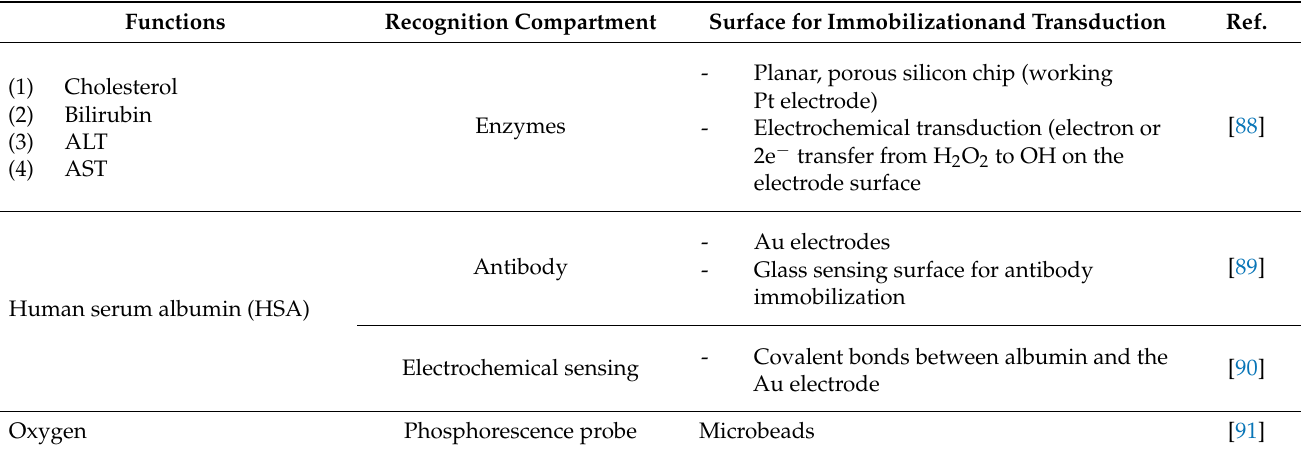
Table 1. Biosensors available for the assessment of liver functions.